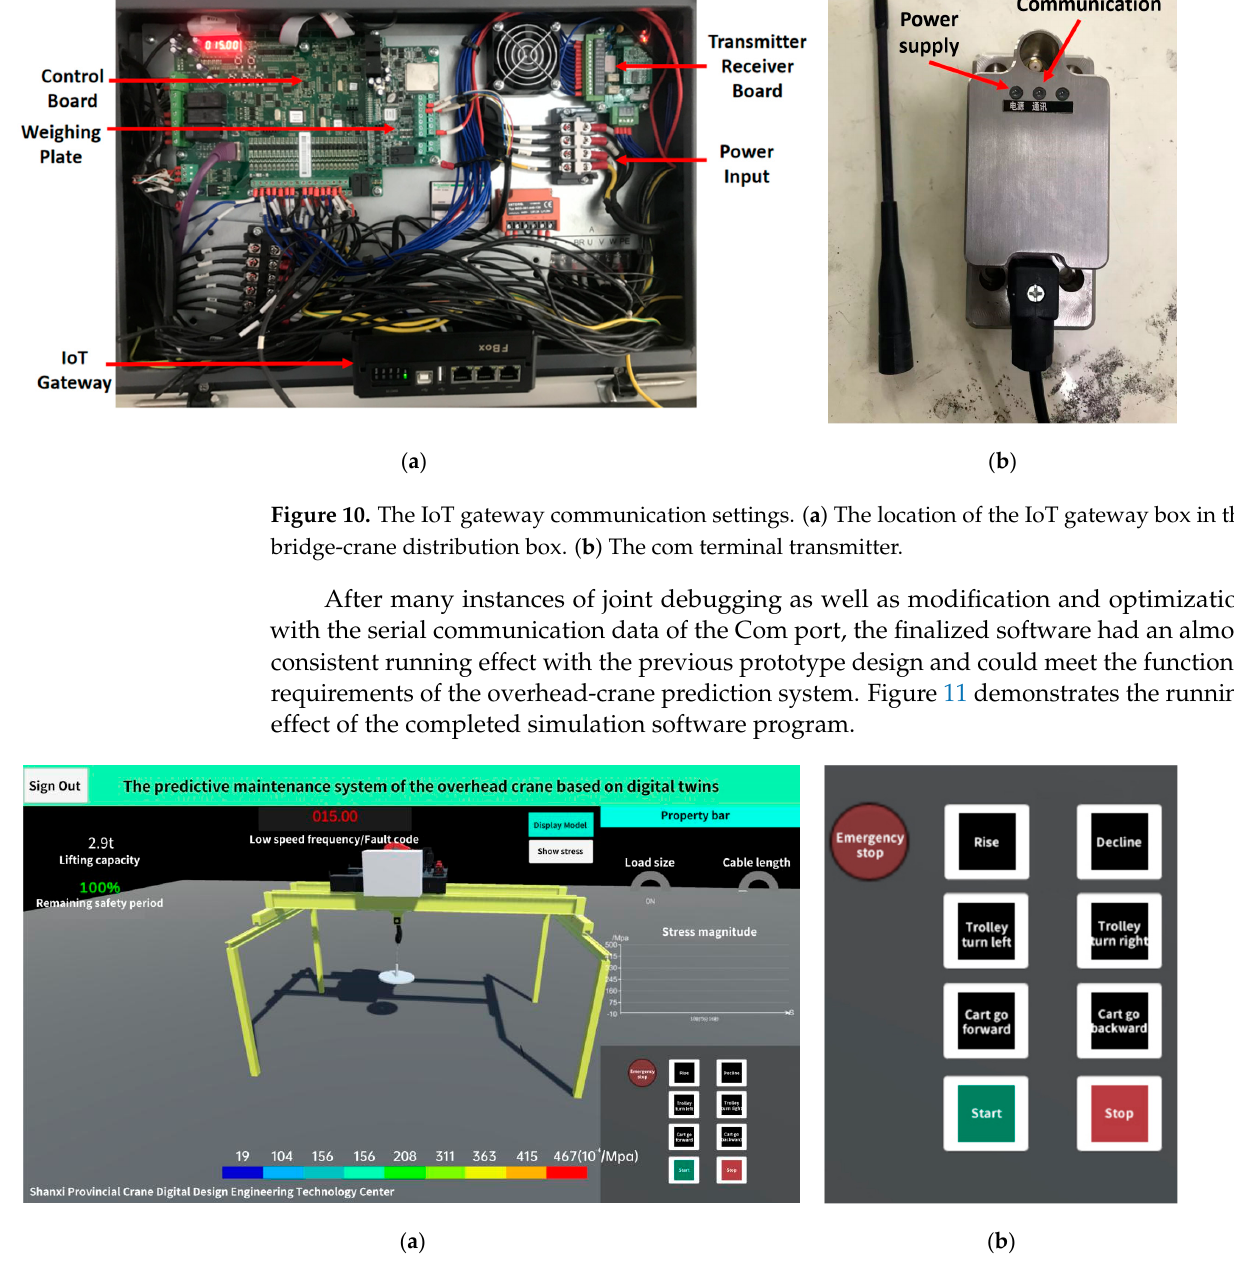
Figure 11. The running e ff ect of the completed simulation software program. ( a ) Main interface. (b) Control interface.